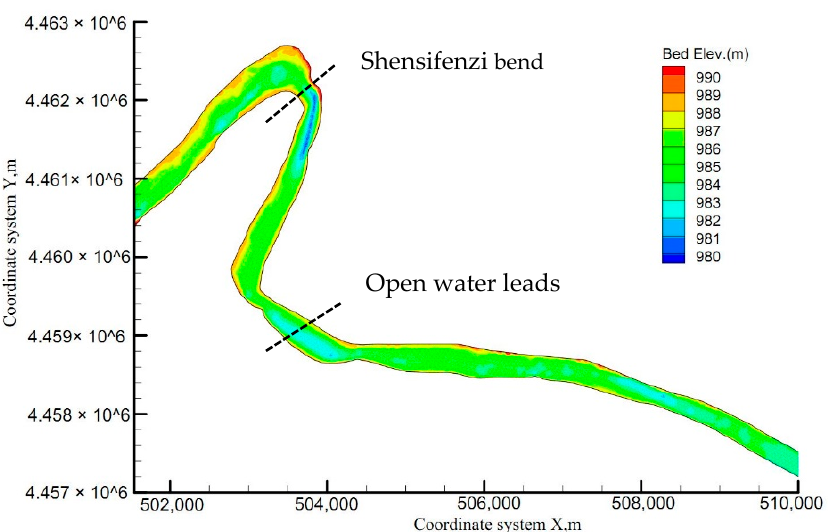
Figure 6. The bed elevation of the Shensifenzi